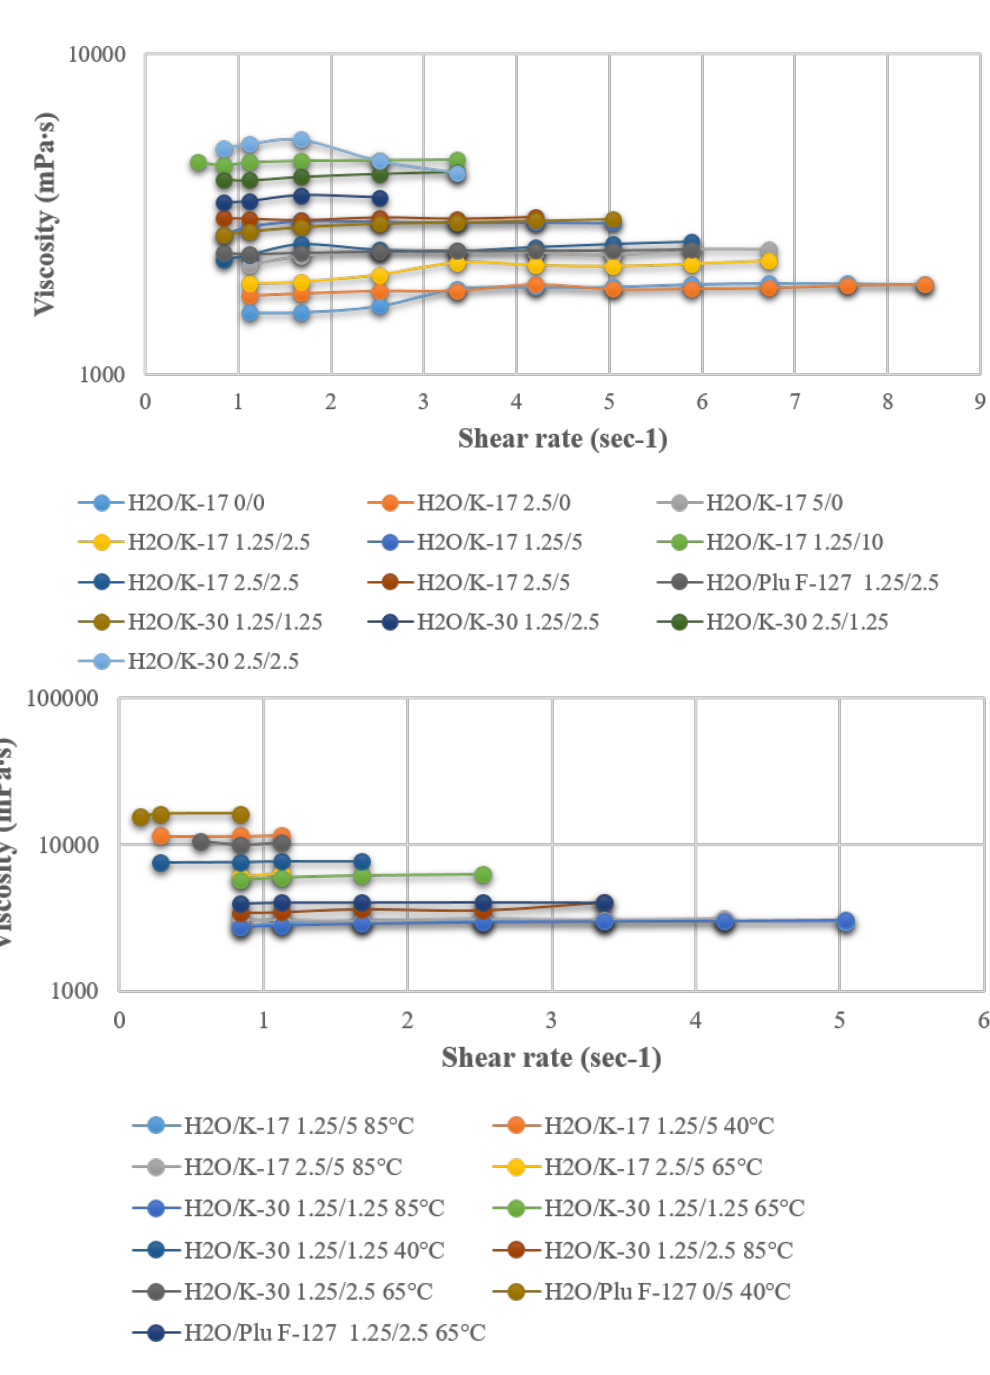
Figure 2. ( a ) Viscosity of the PES dope solution as a function of additive composition at 85 °C; ( b ) dependence of the selected dope composition viscosity on temperature.